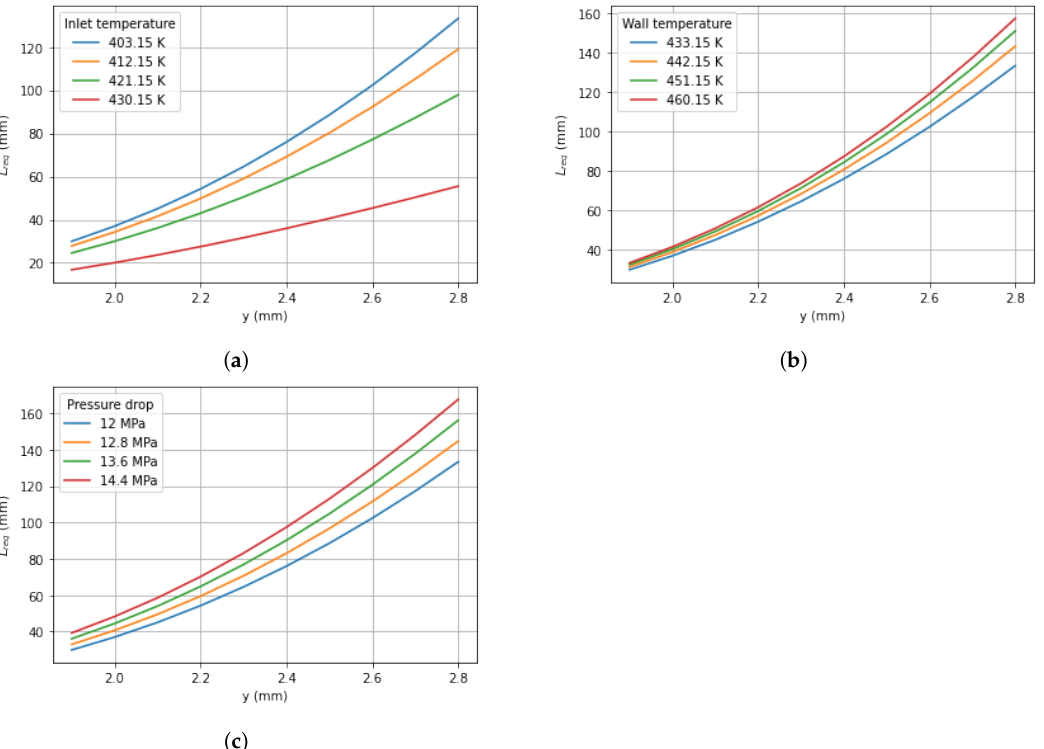
Figure 5. The required length of parallel-plate ( L req ) for the temperature to reach steady state vs. the distance from the center to the wall ( y ). ( a ) Various inlet temperatures; ( b ) various wall temperatures; ( c ) various pressure drop.